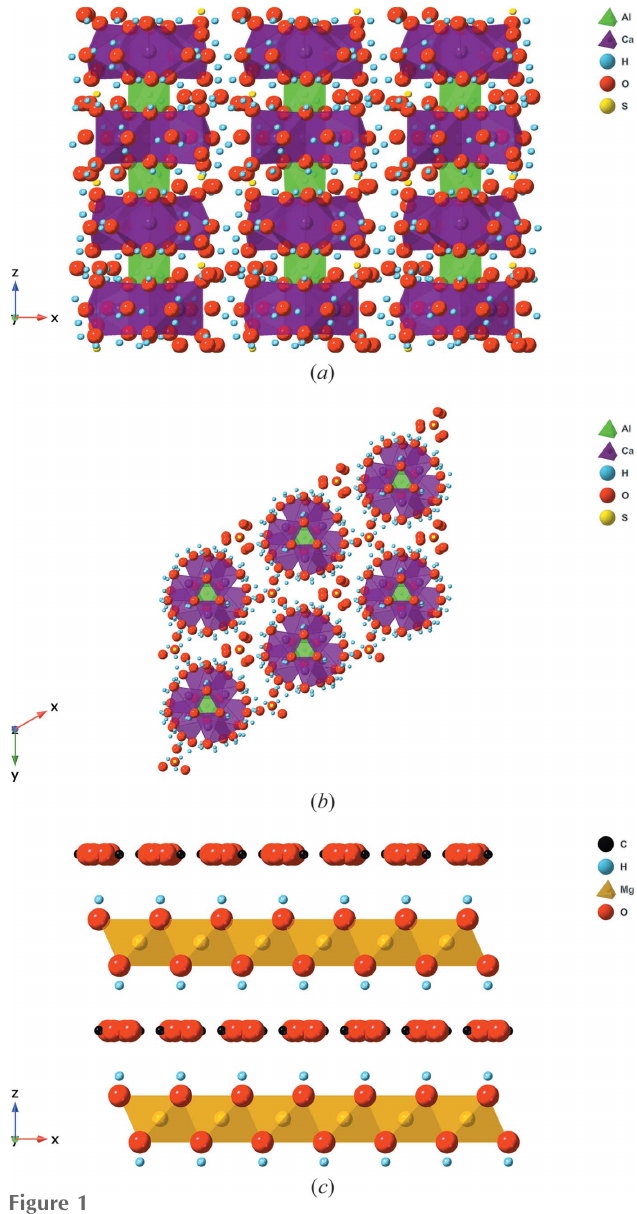
Figure 1 Representation of the ettringite crystal structure shown down the y ( b ) axis [panel ( a )] and the z ( c ) axs [panel ( b )] (Goetz-Neunhoeffer & Neubauer, 2006). Panel ( c ) shows a ‘cross-sectional’ view of the hydrotalcite LDH structure shown down the y ( b ) axis (Radha et al. , 2007), where Mg = Mg or Al. Not to